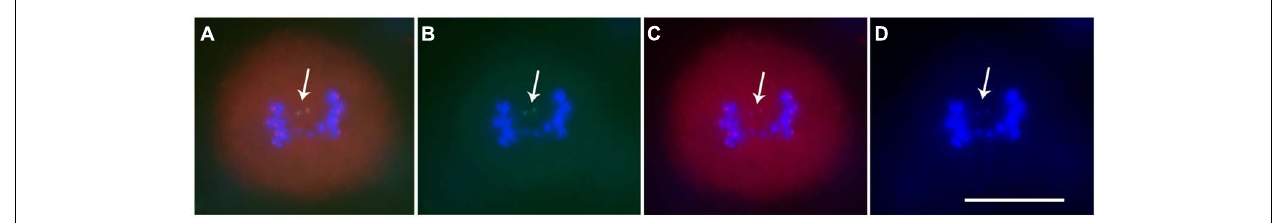
FIGURE 3 | Immunostaining and FISH for minichromosome. (A) Merged image; (B) Green is ZmBs; (C) Red is CENH3, the centromeric histone signals; (D) Blue is DAPI. Arrows indicate that the minichromosome sister chromatids separate in meiosis I and each sister has a functional centromere. Bars = 10 μ m.